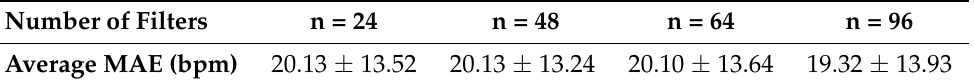
Table 3. Results for different numbers of filters with large kernel size ( k =